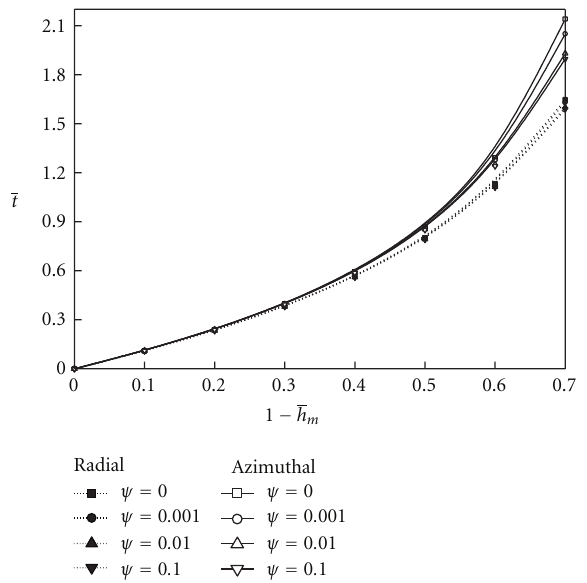
Figure 13: Variation of nondimensional response time t with 1 − h m for di ff erent values of ψ with β = 0 . 05, M = 2, l = 0 . 3, and c = 0 .